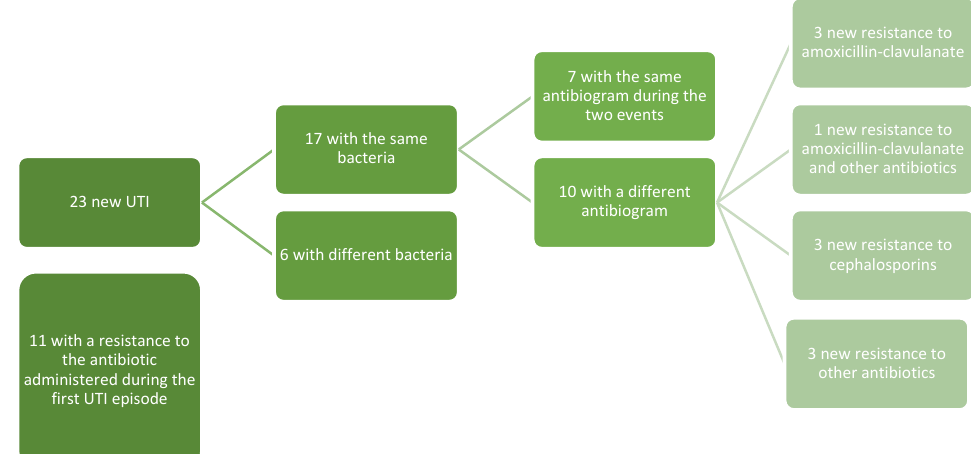
Figure 1. Pattern of the resistances of the first and relapsed UTIs. Figure 2 shows the comparison between patients who underwent short therapy and patients who underwent standard therapy in terms of relapse; a statistically significant difference between groups was observed ( p = 0.002) with lower association (V = 0.28) in the short therapy group.